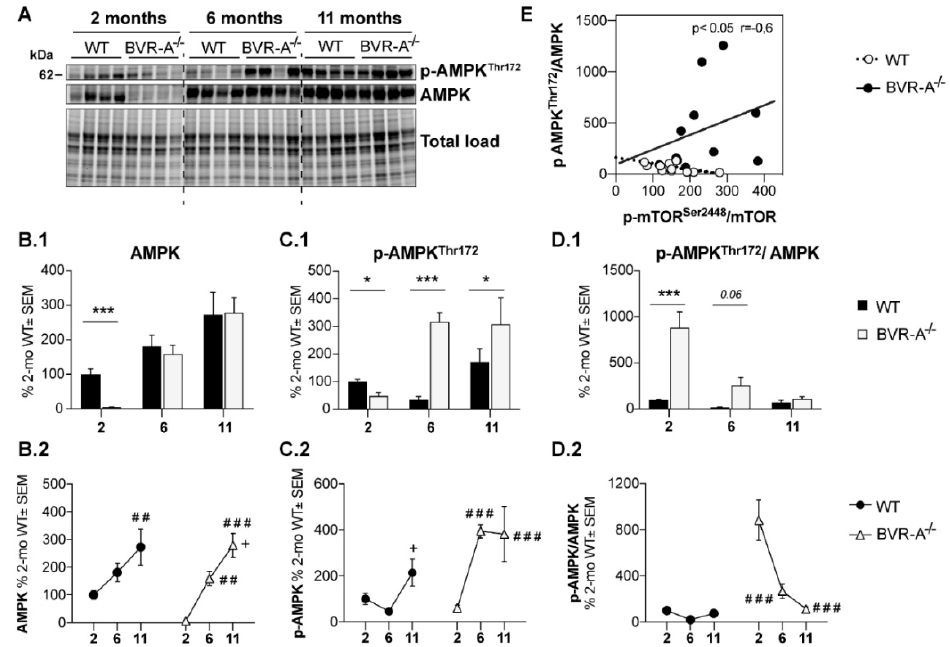
Figure 5. Reduced AMPK levels and activation in the cerebral cortex of BVR-A − / − mice. Representative western blot images ( A ) and densitometric evaluation of AMPK ( B.1 , B.2 ), p-AMPK Thr172 ( C.1 , C.2 ) and p-AMPK Thr172 / AMPK ratio ( D.1 , D.2 ) in the cerebral cortex of WT and BVR-A − / − mice at 2 ( n = 4), 6 ( n = 4) and 11 ( n = 4) months of age. Protein levels were normalized per total protein load. Data are expressed as percentage of WT mice at 2 months set as 100%. Columns were used to show di ff erences among the groups (WT vs. BVR-A − / − ) while dots to show age-associated changes within each group. Data are expressed as Mean ± SEM. For columns: * p < 0.05, *** p < 0.001 vs. WT (2-way ANOVA with Fisher’s LSD test). For dots: ## p < 0.01, ### p < 0.001 vs. 2 months; + p < 0.05 vs. 6 months (2-way ANOVA with Fisher’s LSD test). ( E ) Pearson correlation between p-AMPK Thr172 / AMPK ratio and p-mTOR Ser2448 / mTOR ratio in WT and BVR-A − / −